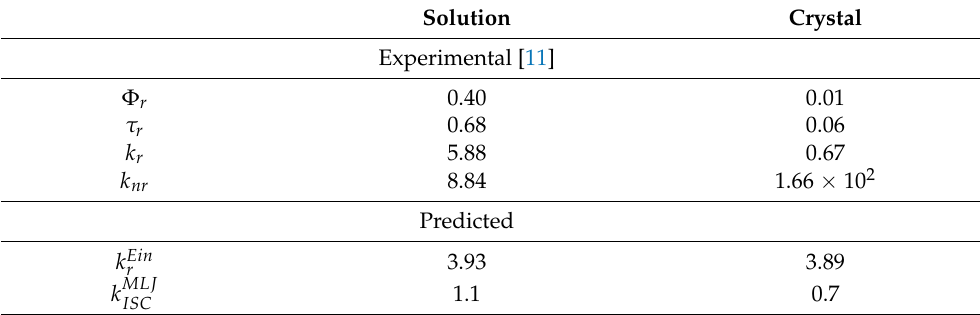
Table 2. Experimental values of fluorescence quantum yield ( Φ f ), radiative lifetimes ( τ r in ns), fluorescence rates ( k exp